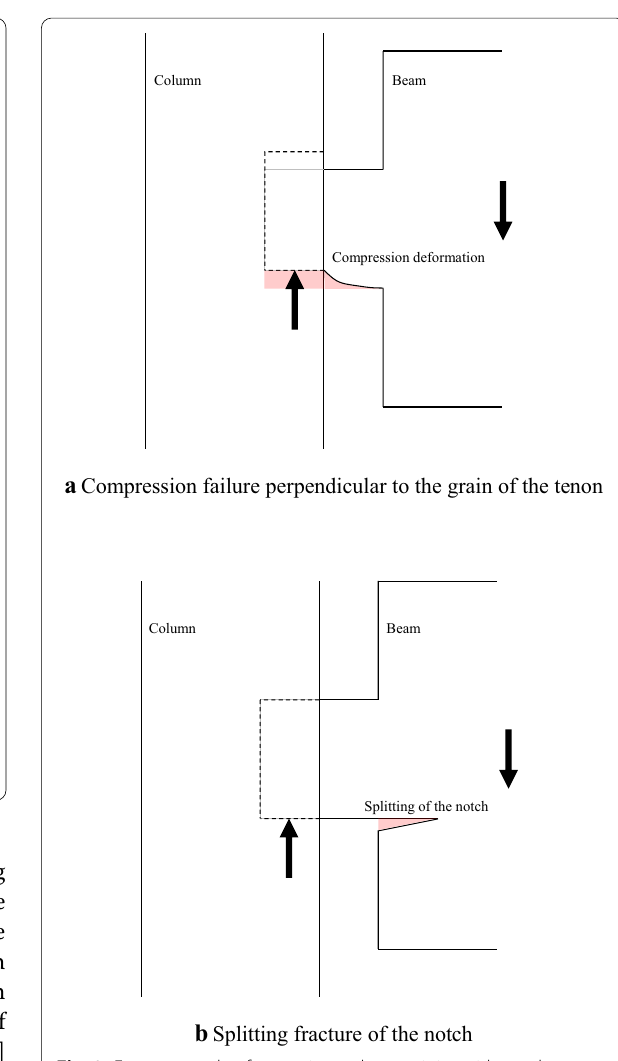
b Splitting fracture of the notch Fig. 2 Fracture mode of a mortise and tenon joint with notches at the top and bottom of the beam